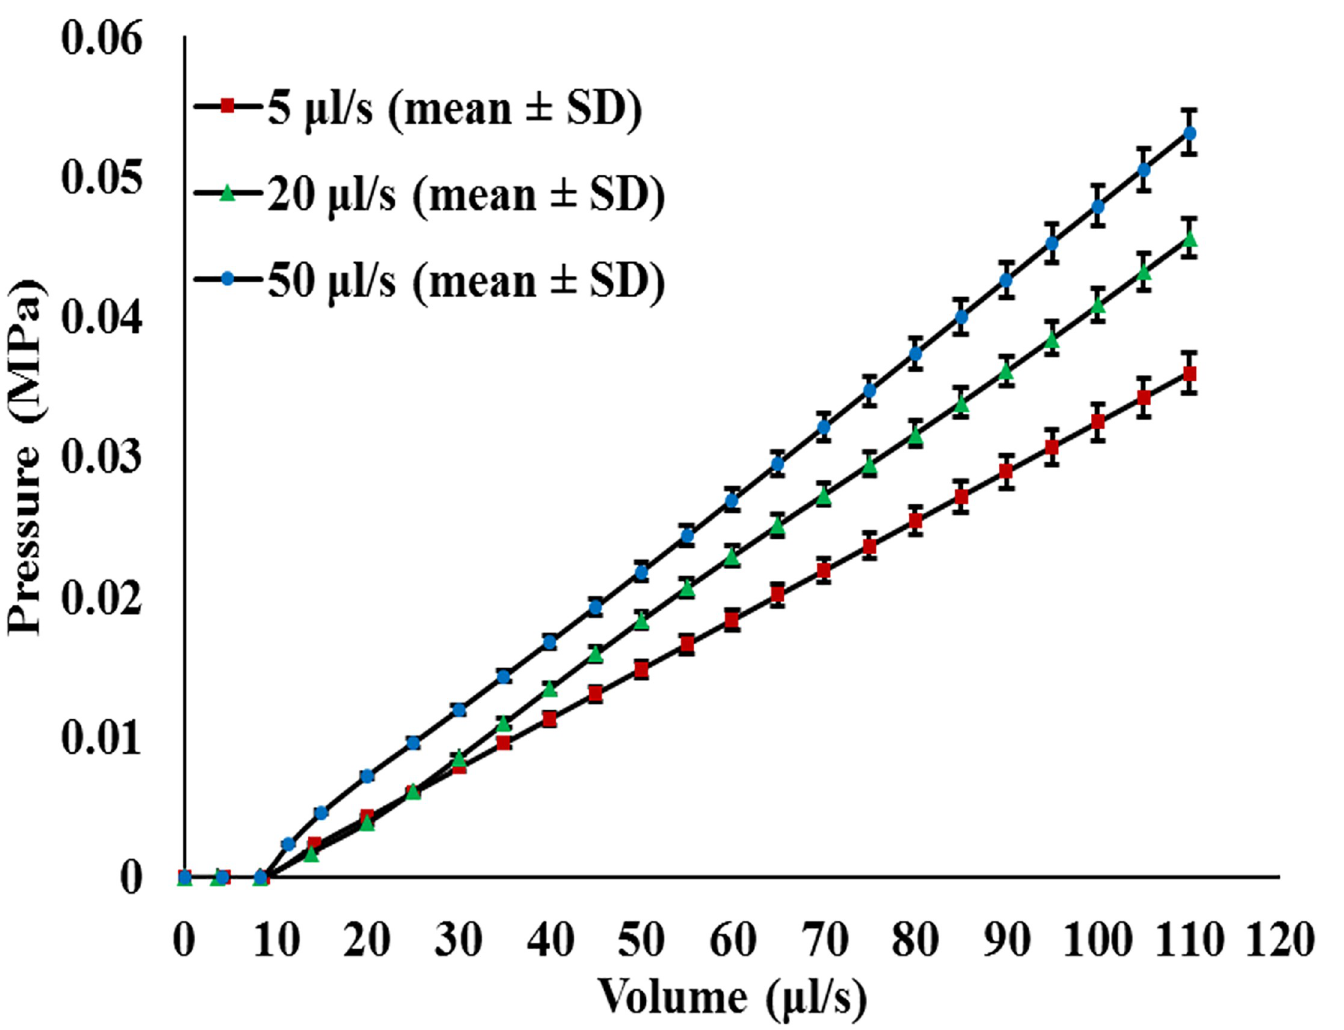
Fig 4. Cavity tests. PVA hydrogel specimens were loaded up to 110 μ l injection volume at loading velocities of 5 μ l/s, 20 μ l/s and 50 μ l/s.